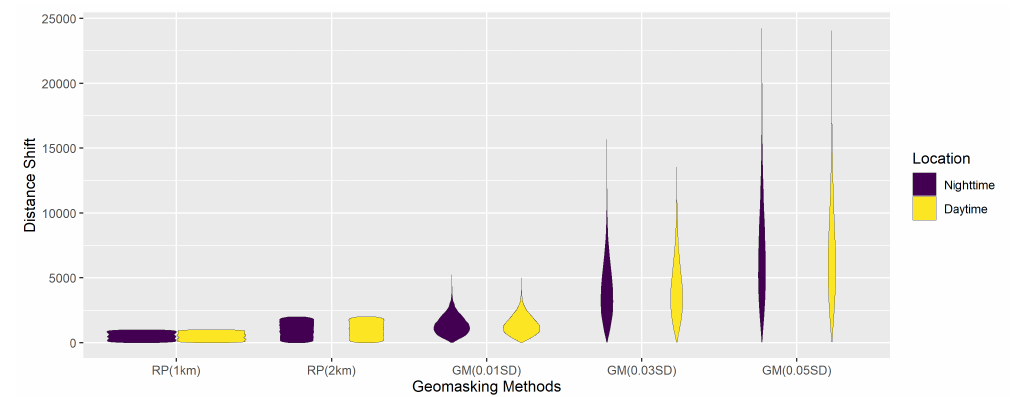
Figure 10: The violin plot of distance shifts of tweet locations after